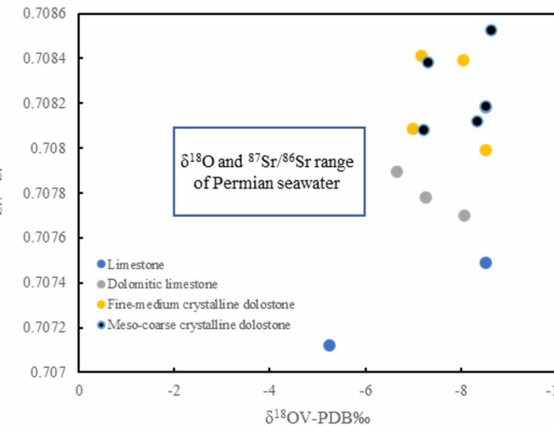
Figure 6. The cross plot of oxygen isotope and strontium